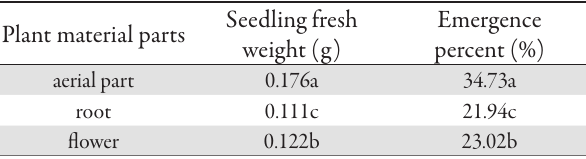
Tab. 3. Means comparison of seedling fresh weight and emergence percent of Amaranthus retroflexus L. affected by plant material parts of Acroptilon repens